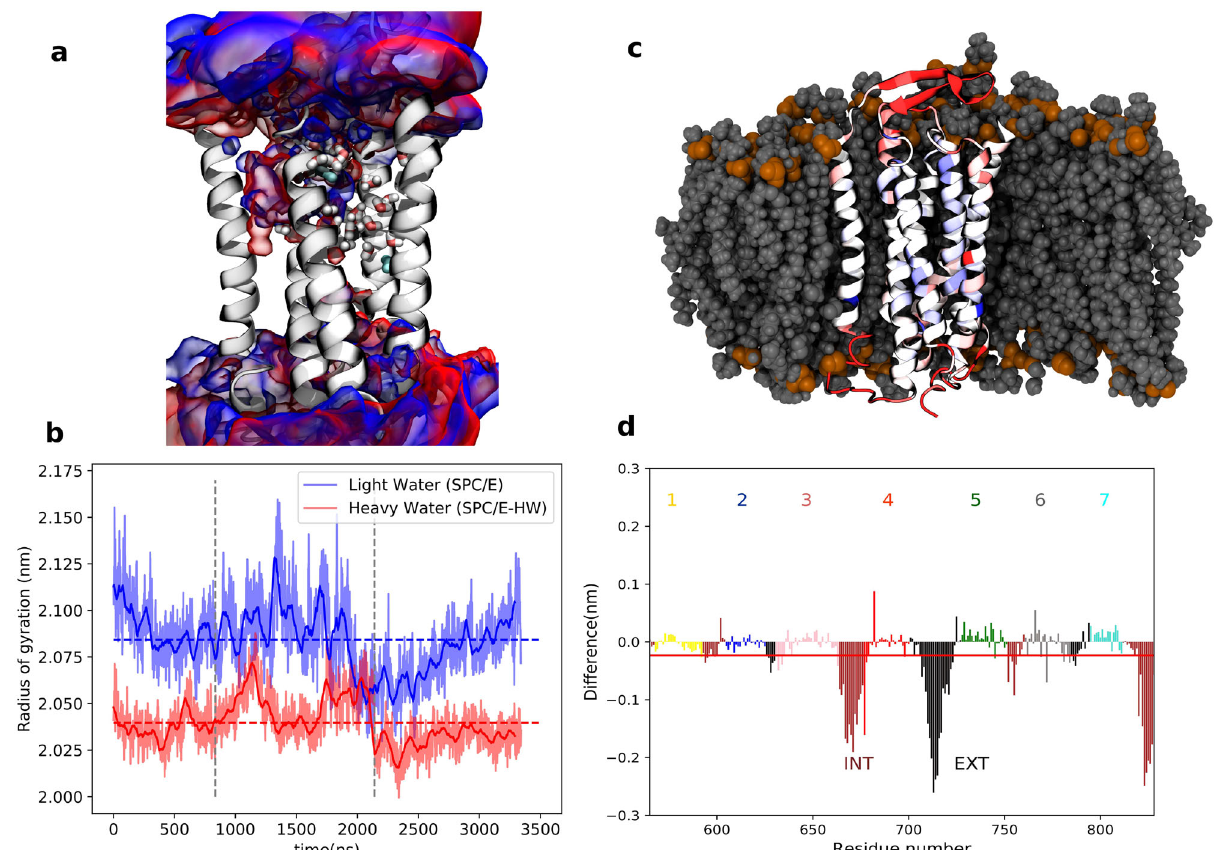
Fig. 7 Differences between the behavior of the transmembrane part of the human sweet taste receptor in H 2 O vs D 2 O base on analysis of three independent microsecond trajectories. a Structure of the TMD of the TAS1R2/TAS1R3 receptor with the probability density (volumetric map) of H 2 O (blue) or D 2 O (red) molecules within 10 Å from the protein evaluated using the VMD VolMap tool from the MD simulations at an isovalue of 0.1. The conserved water molecules in the X-ray templates are shown in cyan color. Water molecules predicted with the software OpenEye 52 are shown in licorice representation. b Time evolution of the radii of gyration in H 2 O (blue) and D 2 O (red) from three microsecond-timescale simulations (separated by vertical dashed lines) with total mean values as dashed lines, showing that the protein is more compact in heavy water. c Representative snapshot of the transmembrane part of the human sweet taste receptor color-coded that red/blue represents parts more/less rigid in D 2 O vs H 2 O. The embedding lipid membrane is represented in gray. d Difference in root mean square fl uctuations in MD trajectories. Negative/positive values mean that structures are more/less rigid in D 2 O than in H 2 O. The red line represents the sum over all residues. INT intracellular, EXT